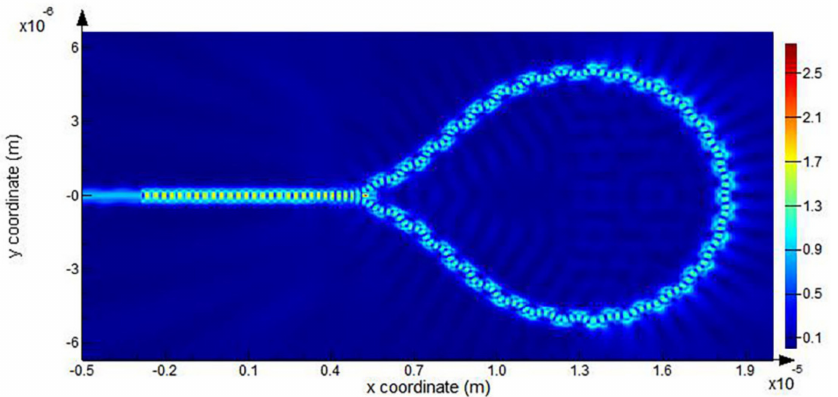
Figure 7. The electric field map of the ELM without 1D PhC structure.